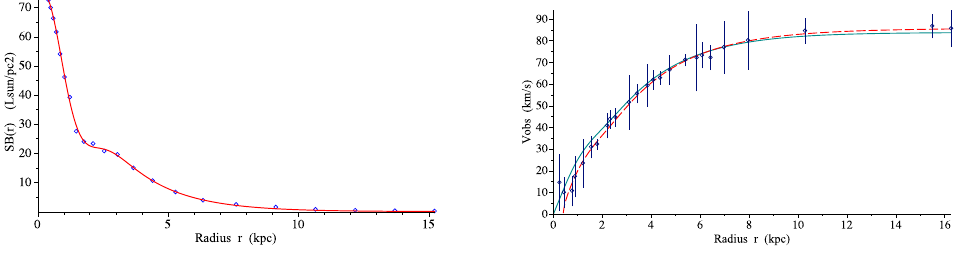
Figure 6. NGC6503 - Type SAcd. Figure on the left : Surface brightness density SB ( r ) = SBdisk ( r ) + SBbulge ( r ) . SBbulge ( r ) = 0. Figure on the right : Rotational velocity curve. ( α , β ) = ( 2.4136,1.7030 ) .